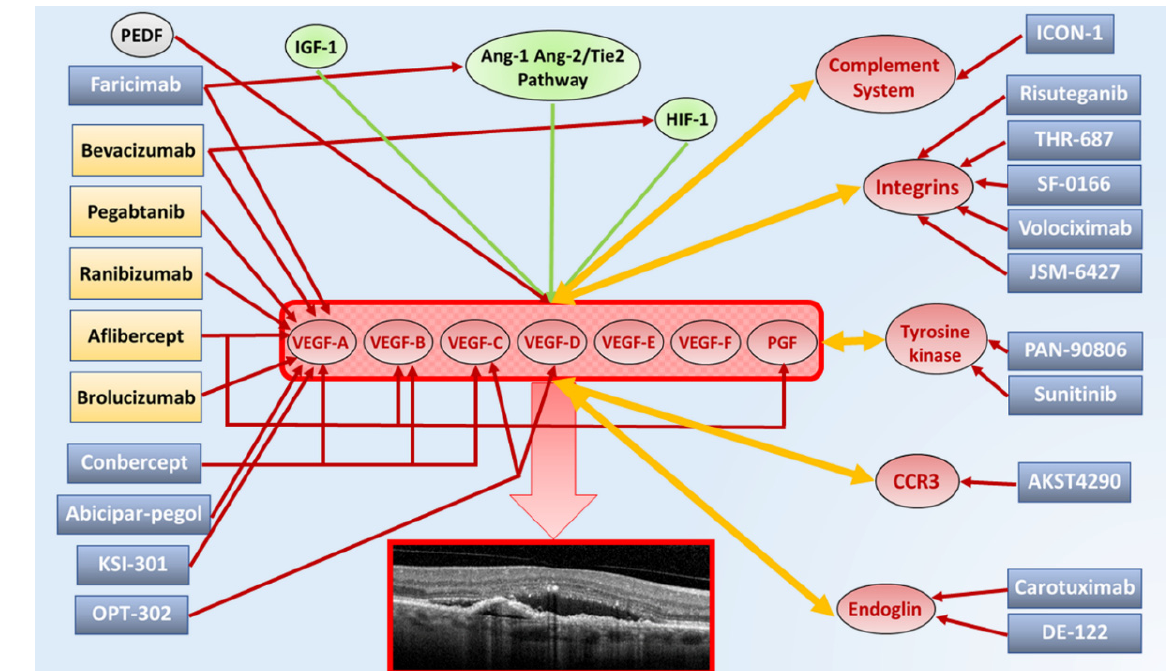
Figure 3. Summary diagram showing present and experimental molecular targets and corresponding intravitreal drugs for exudative age-related macular degeneration (AMD). The upregulation of vascular endothelial grow factor (VEGF) family expression, made by VEGF-A, VEGF-B, VEGF-C, VEGF-D, VEGF-E, VEGF-F and PGF, is responsible for the onset and progression of macular neovascularization and fluid production in exudative AMD. All VEGF molecule subtypes bind to different types of VEGF tyrosine kinase trans-membrane receptors. VEGF family production and release is further stimulated by increased levels of angiotensin 1-2 (Ang-1-Ang-2)/Tie2 pathway, insulin-like growth factor 1 (IGF-1) and hypoxia inducible factor-1 (HIF-1) (green arrows). Furthermore, a natural VEGF inhibitor is represented by PEDF (red arrow), resulting dysregulated in exudative AMD. Currently, approved anti-VEGF molecules include bevacizumab, pegaptanib, ranibizumab, aflibercept and brolucizumab. Although most of current anti-VEGF drugs mainly bind VEGF-A isoforms (red arrows), bevacizumab shows mild affinity also for HIF-1, while aflibercept also binds PGF. Anti-VEGF molecules under investigation include faricimab (VEGF-A isoforms + Ang-1-Ang-2/Tie2 pathway), conbercept (VEGF-A + VEGF-B + VEGF-C isoforms), abicipar-pegol (VEGF-A isoforms), KSI-301 (VEGF-A isoforms) and OPT-302 (VEGF-C + VEGF-D isoforms). Exudative AMD is also characterized by upregulation of complement system, integrins, tyrosine kinase, eotaxin C-C chemokine receptor type 3 (CCR3) and endoglin, which contribute to the increased production and release of VEGF family and often are themselves stimulated by the increased level of VEGF isoforms (orange arrows). Several molecules are currently under investigation through multicenter clinical trials, targeting these cofactors of the neovascular process, including complement system inhibitors (ICON-1), integrins inhibitors (risuteganib, THR-687, SF-0166, volociximab, JSM- 6427), tyrosine kinase inhibitors (PAN-0806, sunitinib), CCR3 inhibitors (AKST4290) and endoglin inhibitors (carotuximab,